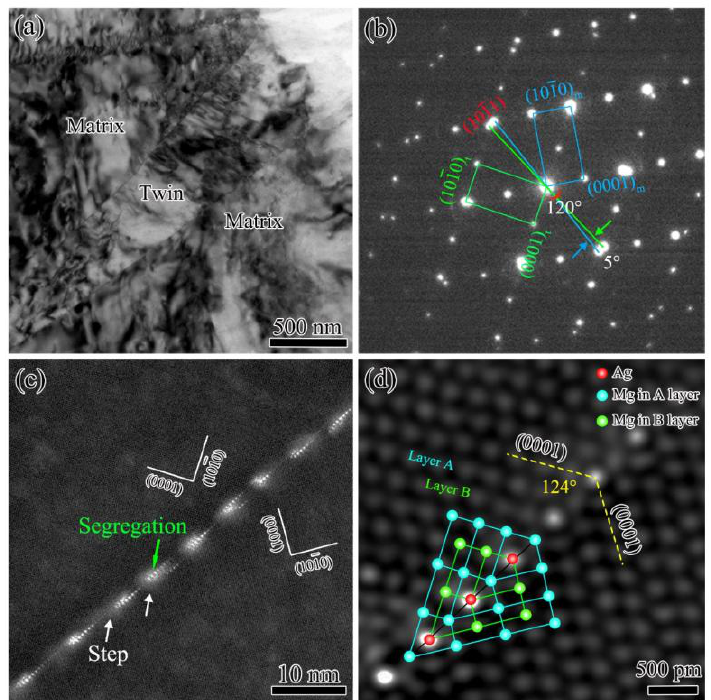
Figure 1. TEM images of {101 ̅ 1} twin in Mg-Ag alloy from [12 ̅ 10] direction: ( a ) A low magnified bright field TEM image; ( b ) a selected area diffraction pattern, ( c ) a high-resolution HAADF-STEM image, and ( d ) an atomic scaled HAADF-STEM image marked by an atomic model. The red spheres represent Ag atoms. Blue and green spheres represent Mg in A layer and B layer, respectively.